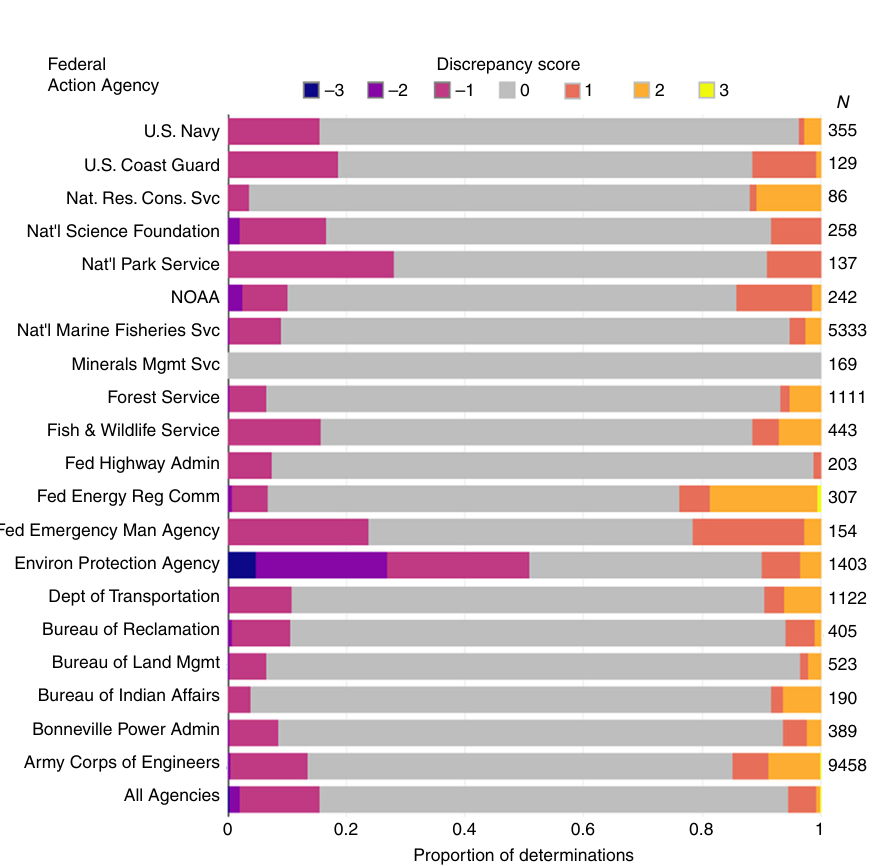
Bold numbers show the ‘ discrepancy ’ score assigned to a given combination, indicating the degree of agreement (positive values) or disagreement (negative values) *NMFS must make a Jeopardy/No jeopardy determination following an ‘ LAA ’ fi nding during informal consultation